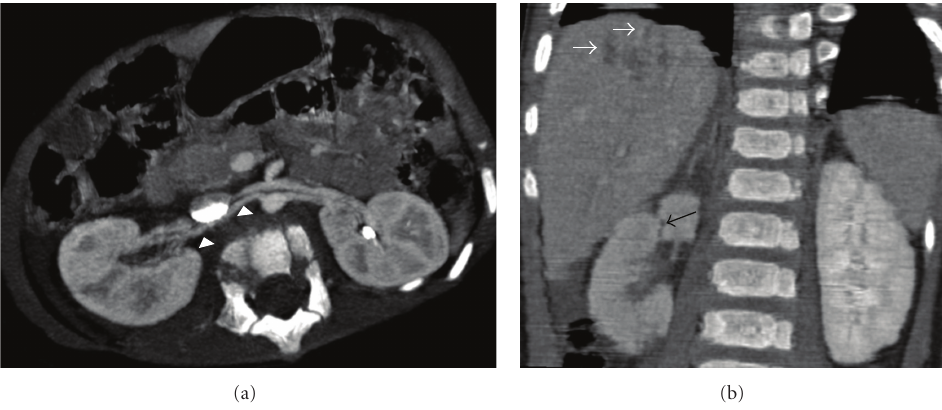
Figure 2: Axial curved reformatted image and coronal image of the abdomen demonstrating a patent renal artery with normal calibration (arrows) and opacification of the right kidney. Note laceration on the upper pole of the right kidney (black arrows) and in the liver (white